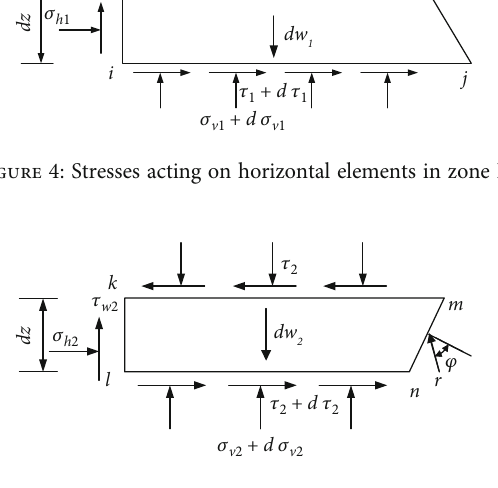
Figure 5: Stresses acting on horizontal elements in zone II.